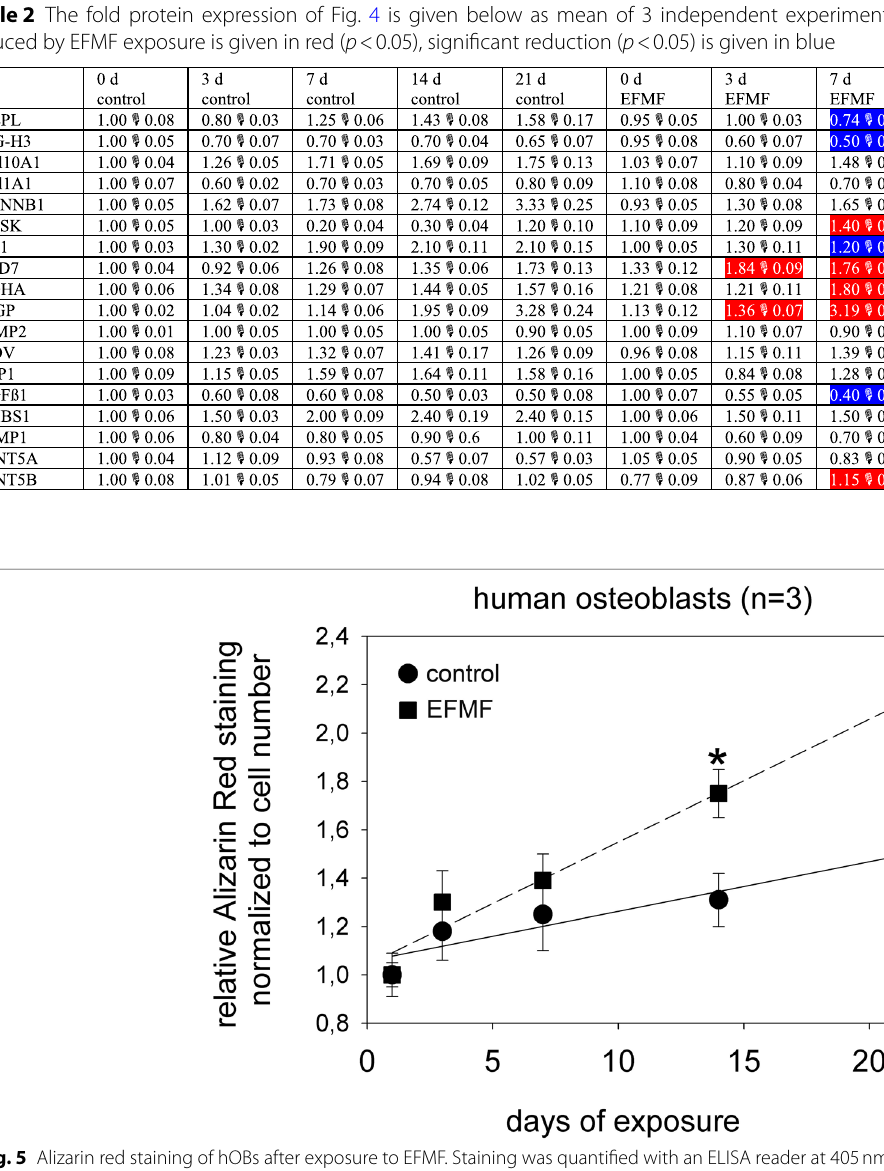
3, * p < 0.05 compared to control cells (normalized on cell = =